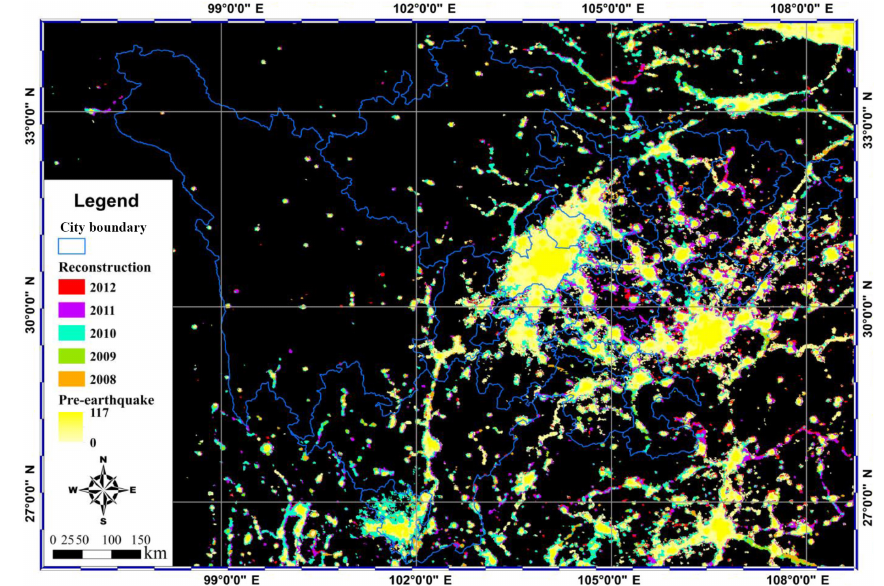
Figure 10. Distribution of new lighting areas after the